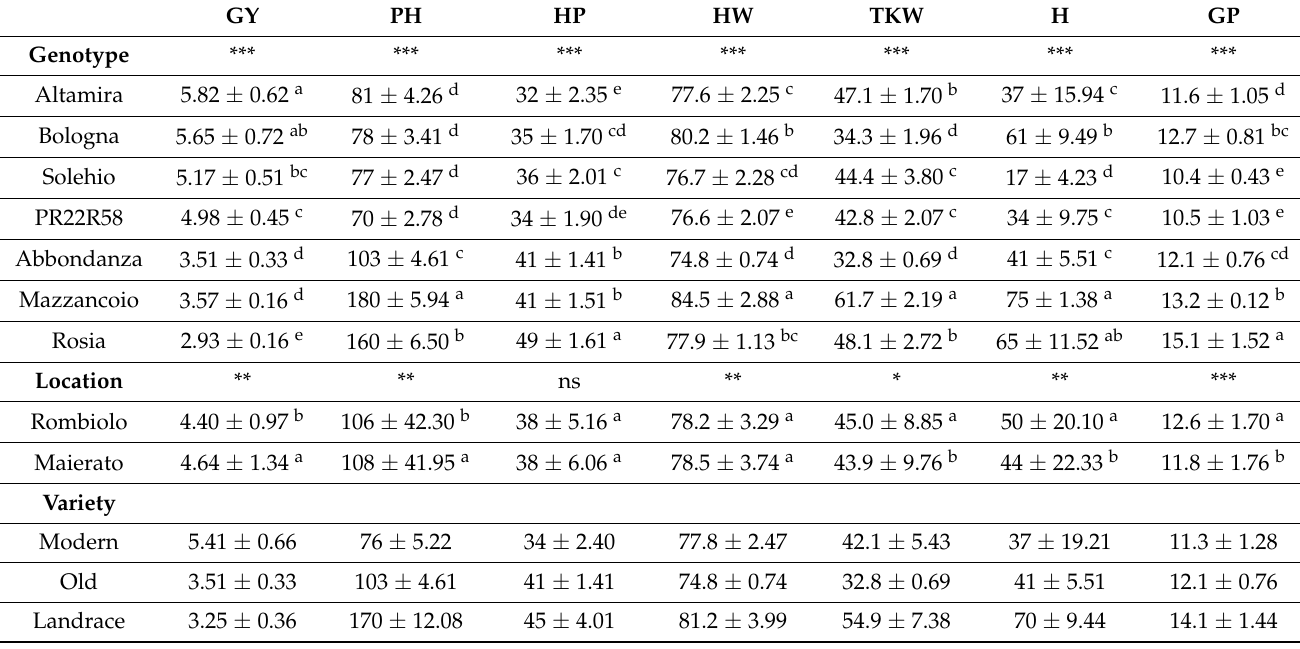
Table 2. Bio-agronomic and grain quality